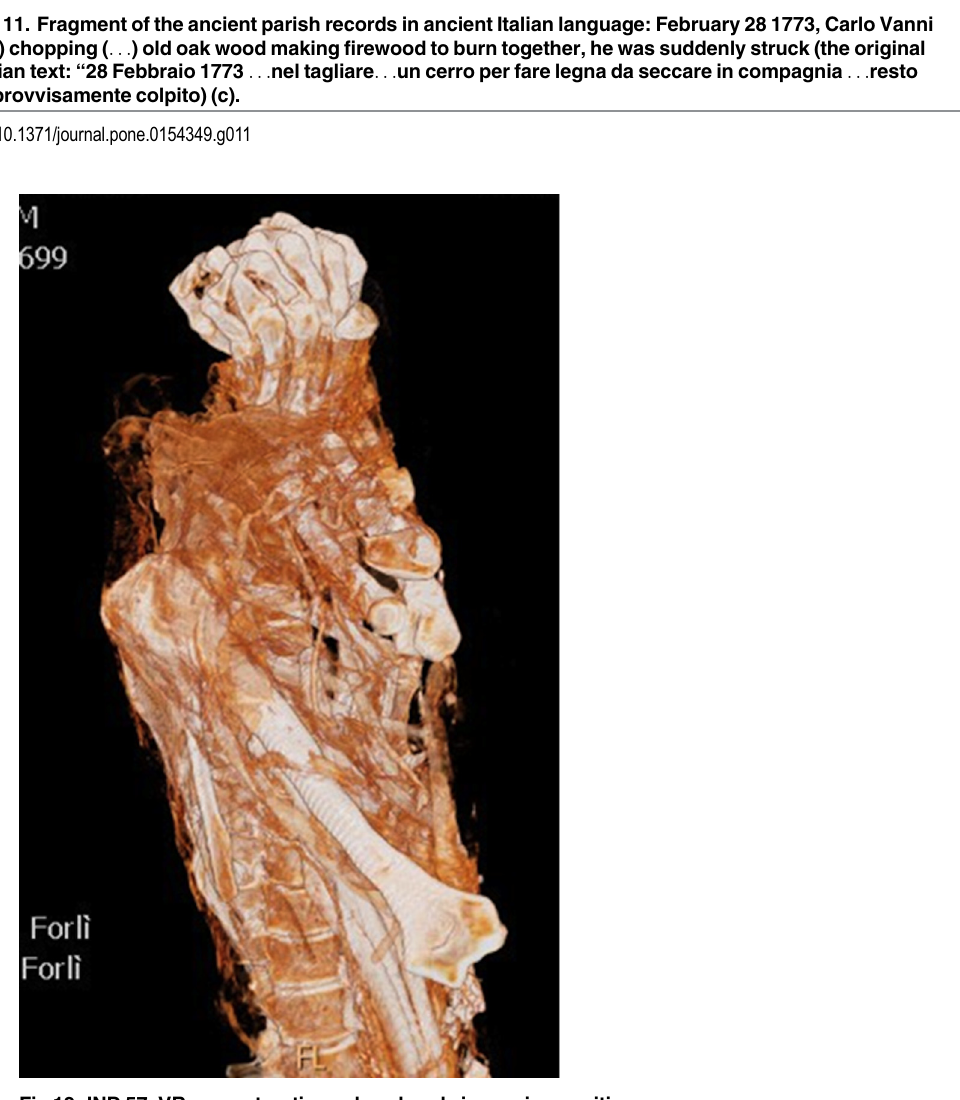
Fig 12. IND 57: VR reconstructions show hands in praying position.